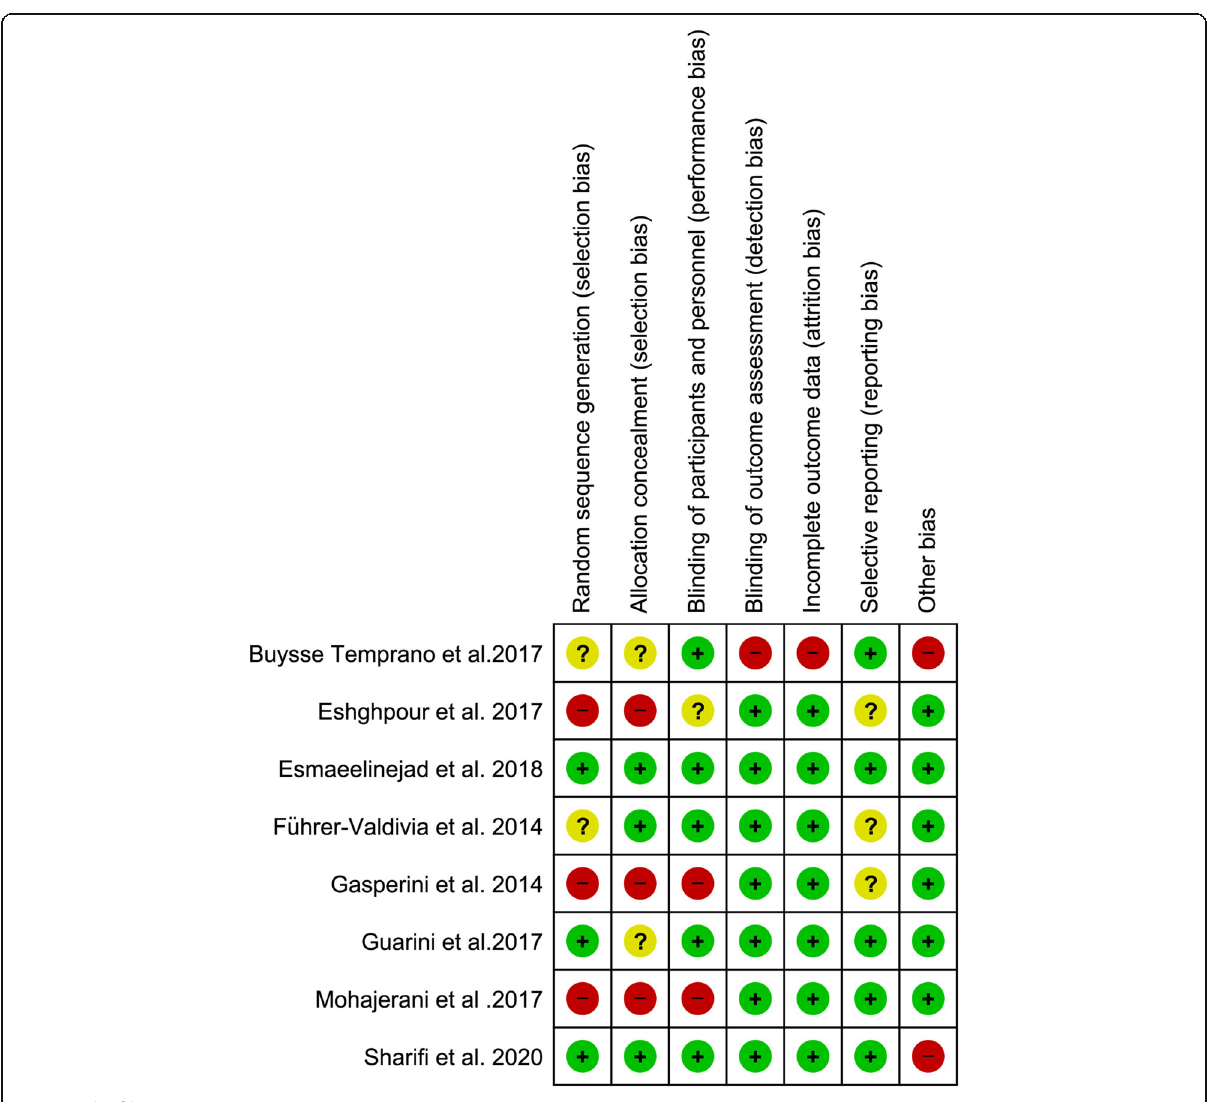
Fig. 3 Risk of bias